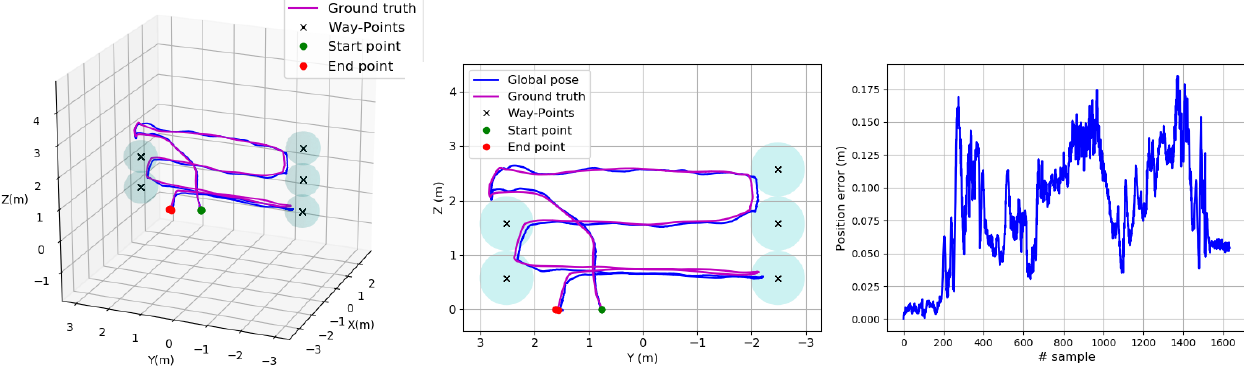
Figure 14. Autonomous sweeping: ( left ) estimated and true paths, ( middle ) 2D projection of the resulting path, ( right ) position estimation error. In the plots, × in the center of a blue sphere denotes a way-point. (All values are in